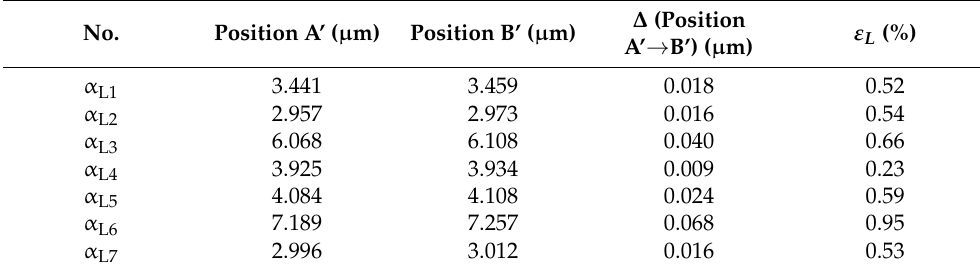
Table 2. Calculation of ε L values of α L phase (Figure 12) from positions A’ to B’. No. Position A’ ( µ